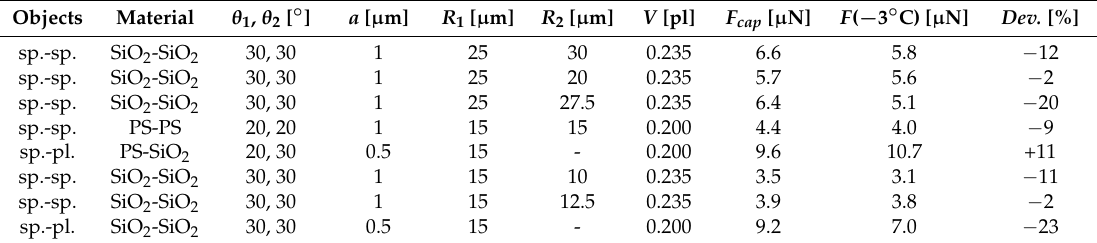
Table 2. Comparison of the measured pull-off forces ( F ) with the calculated capillary forces ( F cap ). Objects